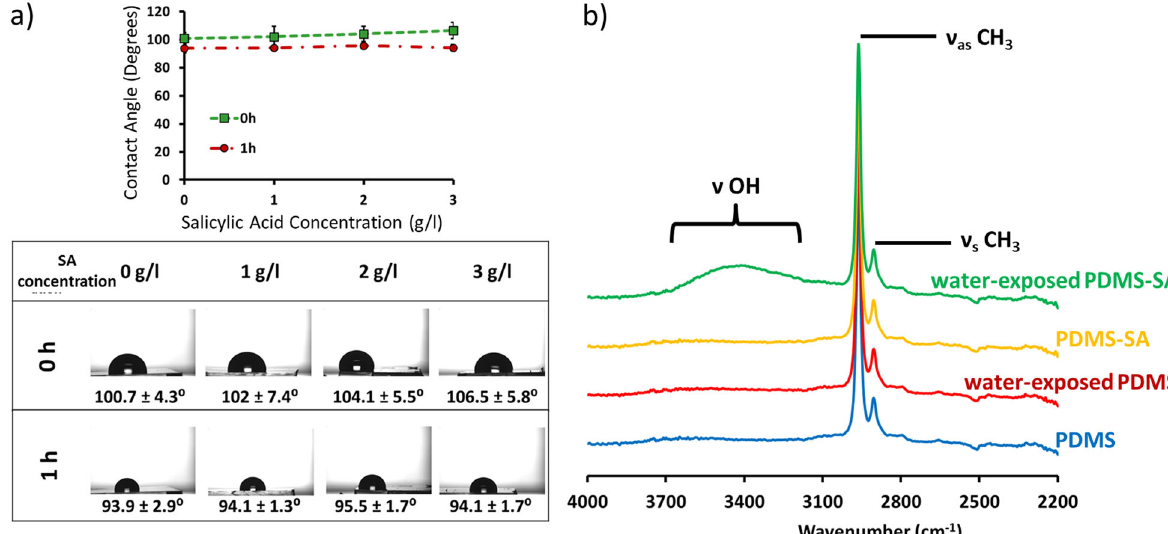
Fig. 6 Effect of SA on surface properties of PDMS and PDMS-SA samples. a Static contact angle for the model buffer containing different concentrations of Salicylic acid (SA) over PDMS at contact times of 0 h and 1 h, showing that the presence of SA in the media does not affect the wettability of PDMS surface; b ATR-FTIR spectra of PDMS and PDMS-SA samples before and after 24 h of contact with the aqueous model buffer, simulating a typical release experiment.